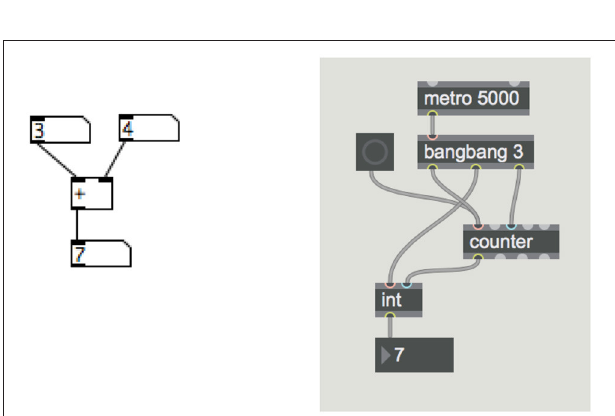
(section Why Is Music Different), models of musical time (section Models of Time and Scheduling), models for sound synthesis and audio signal processing (section Models for